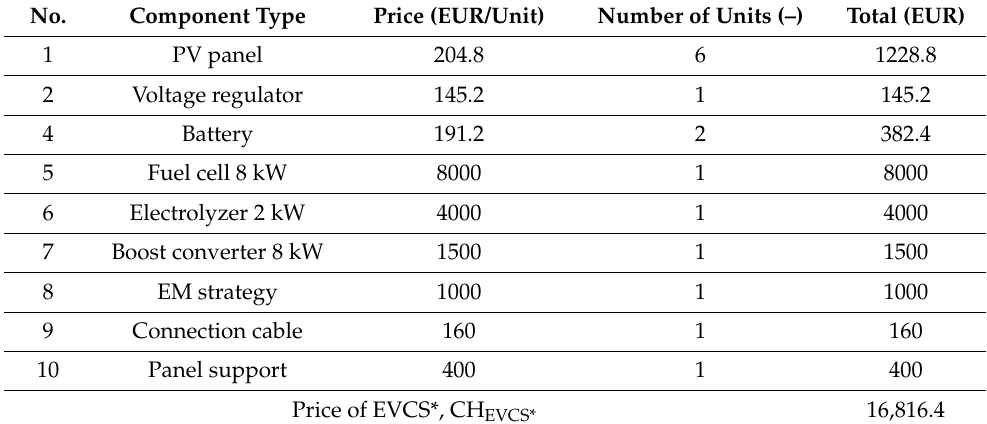
Table 7. The investment cost for the EVCS based on the FC/ELZ/RES DCmG (EVCS*). No. Component Type Price